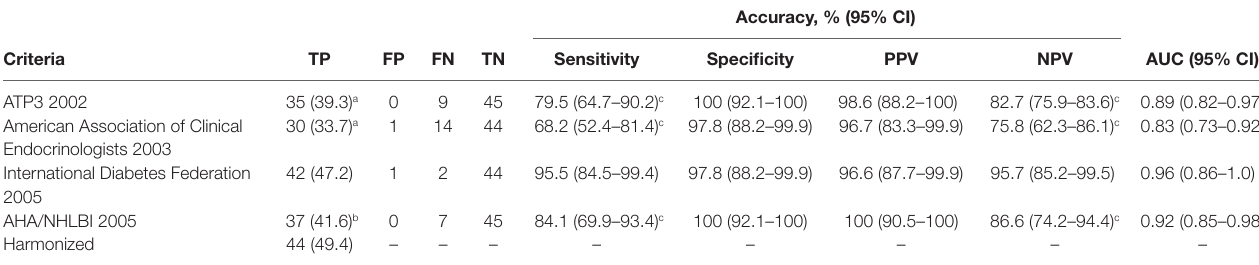
TaBle 6 | Diagnostic accuracy of different metabolic syndrome criteria in 89 patients with